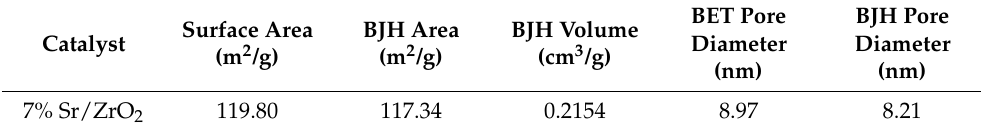
Figure 2. Characterization of Sr/ZnO 2 : ( a ) XRD analysis, ( b ) BET analysis, ( c ) FTIR, and ( e-1 – 3 ) SEM analysis. Table 2. Structural properties of catalyst.